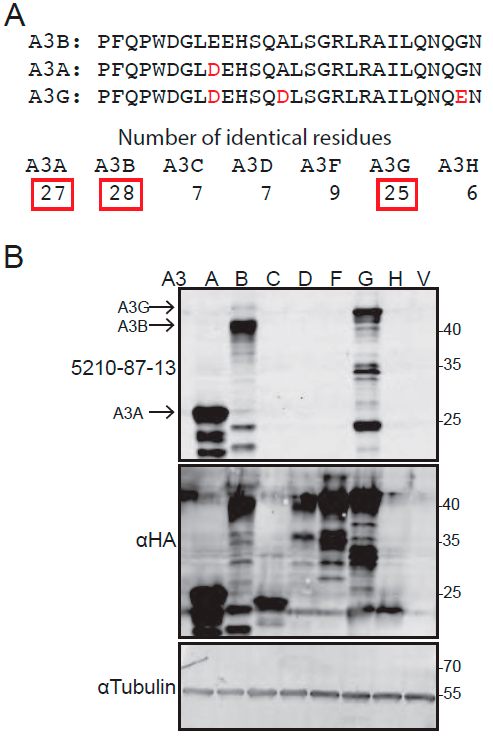
Figure 1. Peptide selection and anti-APOBEC3 reactivity of the 5210-87-13 mAb by immunoblot: ( A ) Comparison of the C-terminal region of A3B with the corresponding regions of A3A and A3G; and ( B ) anti-A3 reactivity of 5210-87-13, with anti-HA and anti-Tubulin blots as expression and loading controls, respectively. Faster migrating bands are likely degradation products, as minimal background is observed in lanes with A3C, A3D, A3F, A3H, and the vector control (V).